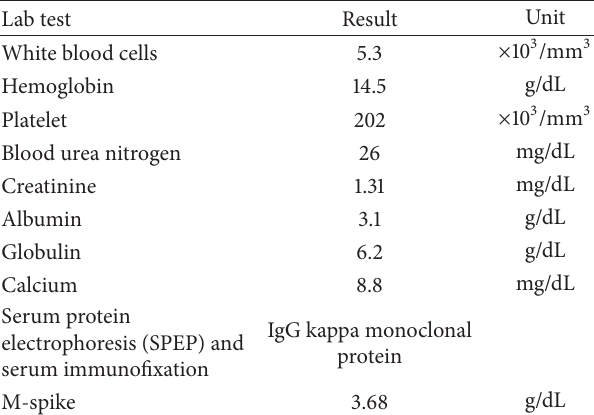
Table 2: Laboratory test results upon initial